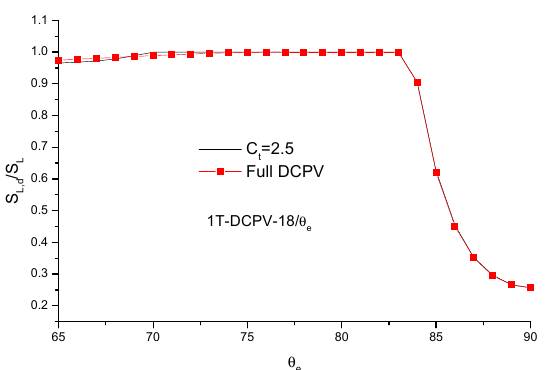
Figure 15. Effects of θ e on annual leakage loss contributed by sky diffuse radiation for 1T-DCPV-18/ θ e .